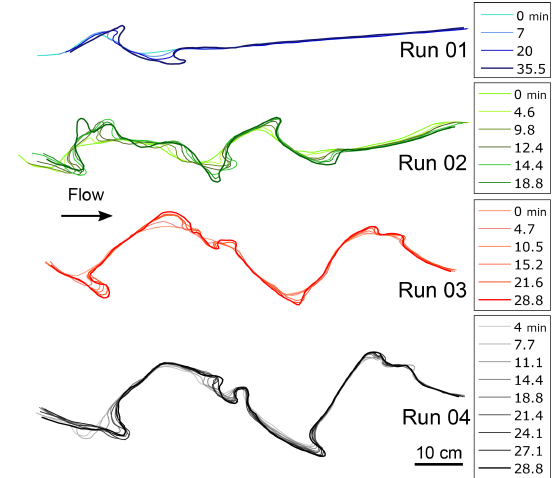
Figure 11. Planform evolution for four different centimeter-scale laboratory meltwater meandering channel